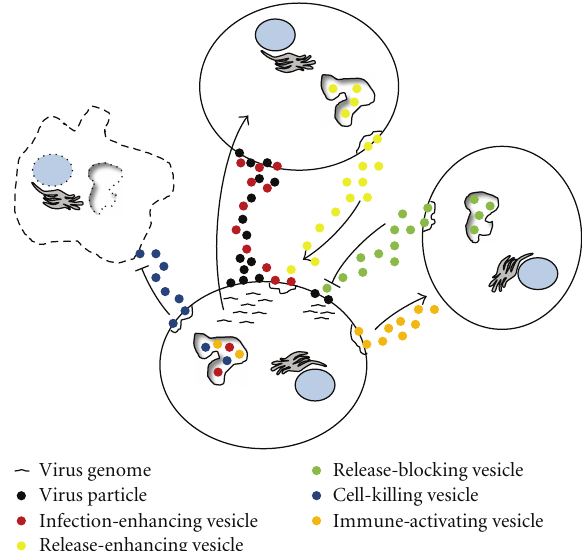
Figure 2: Heterogeneity of microvesicle function during virus infection. Microvesicles with diverse e ff ects on virus spread are indicated by di ff erent colors. Microvesicles from infected cells can a ff ect noninfected cells, enhancing infection, or killing incoming immune cells, or act to activate immune cells to viral antigens. Microvesicles from noninfected cells can either enhance or block virus release from the infected cell and modulate the immune response. Cell with dashed lines is undergoing cell